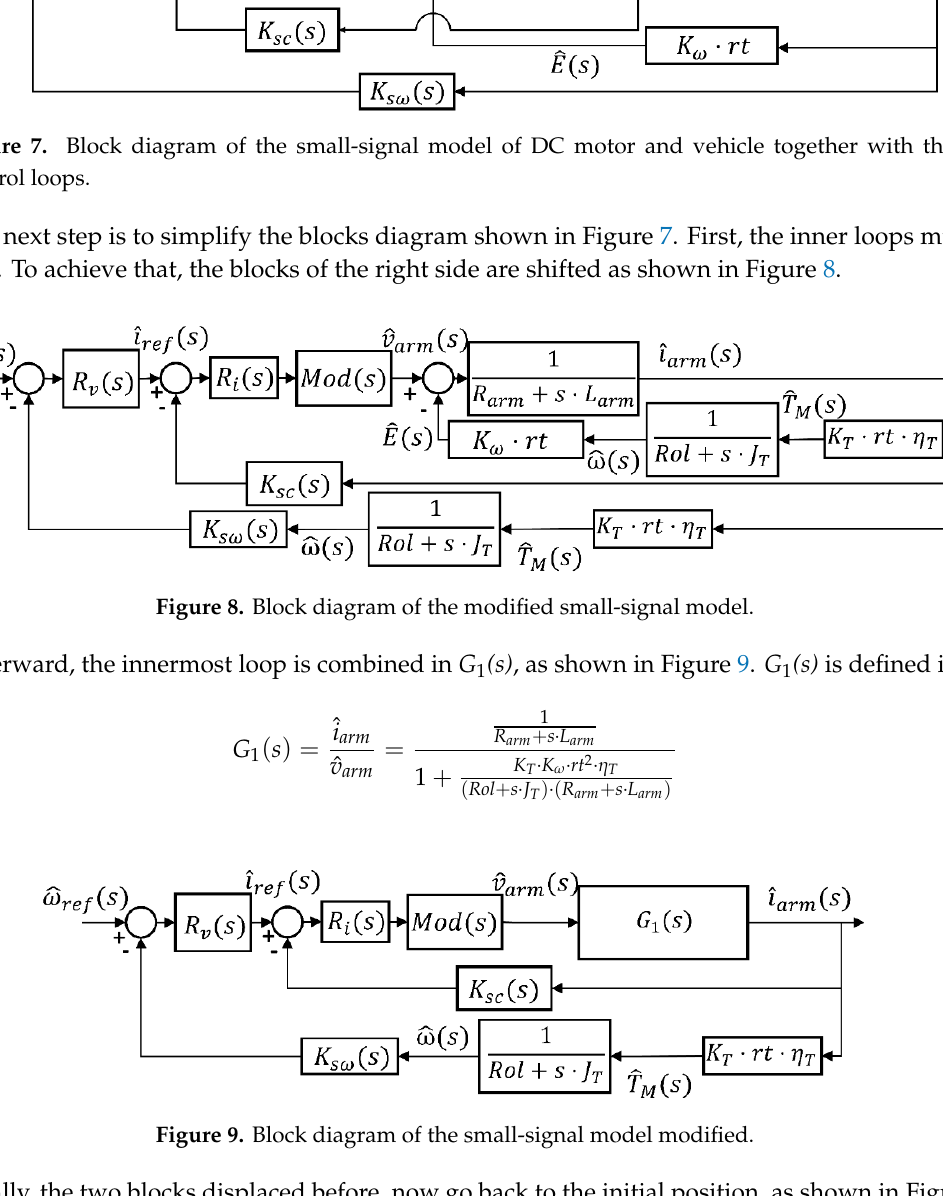
Figure 9. Block diagram of the small-signal model modified.